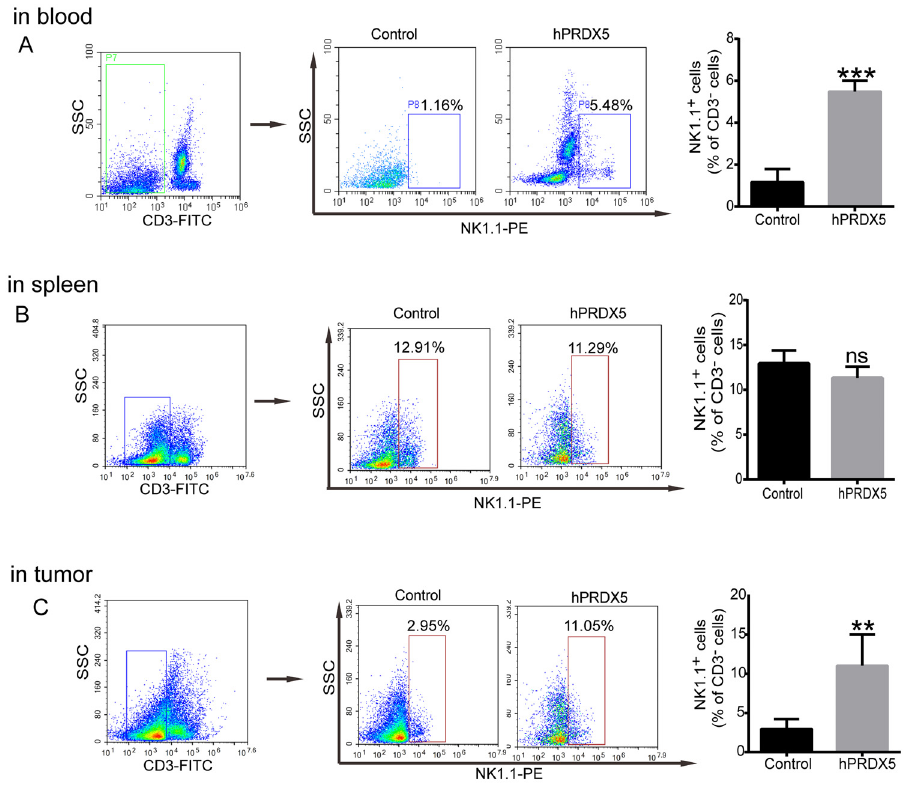
Figure 3. Effect of human peroxiredoxin-5 (hPRDX5) on the proportion of natural killer (NK) cells in peripheral blood ( A ), spleen ( B ), and tumor ( C ) tissues of mice. Data are reported as means ± SD. **P o 0.01, ***P o 0.001 compared with the control ( t -test). ns: not signi fi